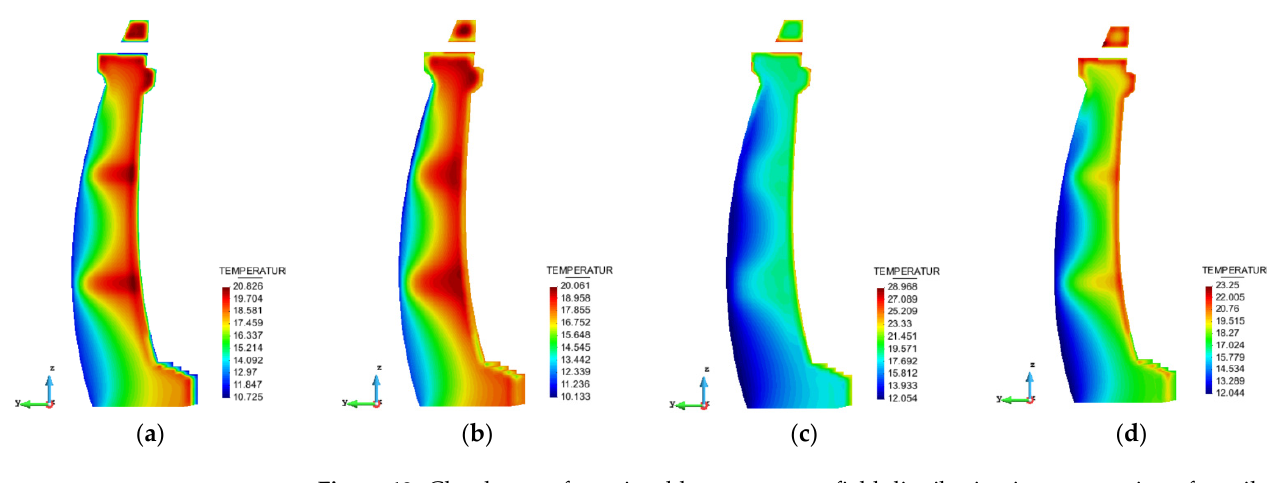
Figure 19. Cloud map of quasi-stable temperature field distribution in cross-section of cantilever No. 16 dam section under design reservoir water temperature. (unit: °C). ( a ) January; ( b ) April; ( c ) August; ( d ) November.